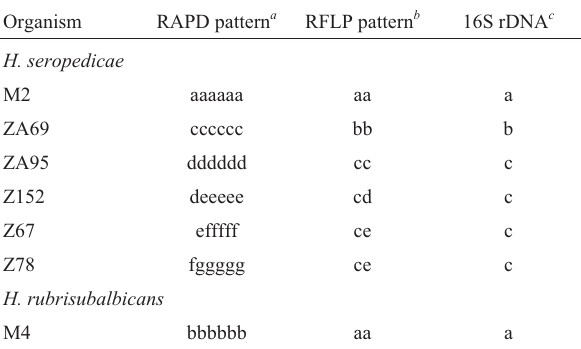
Table 2 - Genotypic characterization of Herbaspirillum spp., as revealed by RAPD and RFLP profiling and 16S rDNA sequence